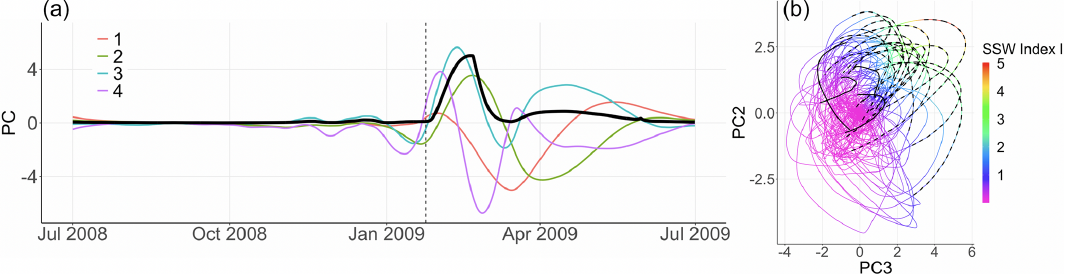
Figure 4. (a) First four principal components for winter 2008/09 obtained using PCA on polar-cap-averaged temperature anomalies at pressure levels 150, 125, 100, 70, 50, 30, 20, 10, 7, 5, 2, and 1hPa with a temporal embedding of T = 2 months. Vertical dashed line: central date of the 2009 SSW. Solid black line: SSW index I over the same period defined as a function of the second and third principal components as in Eq. (2). (b) PC T against PC T for all winters from a PCA on polar-cap-averaged temperature anomalies with a T = 2 months temporal 3 2 embedding. Dashed black lines: 2 weeks prior to and after the onset of SSW events, as defined by the zonal wind reversal criterion at 10hPa and 60 ◦ N. Solid black lines: 2 weeks prior to and after the onset of SSW events, as defined by the zonal wind reversal criterion at 10hPa and 60 ◦ N, with fast recovery. The temporal evolution of the SSWs along the black curves is counterclockwise. The value of the SSW index I(t) is given by the color